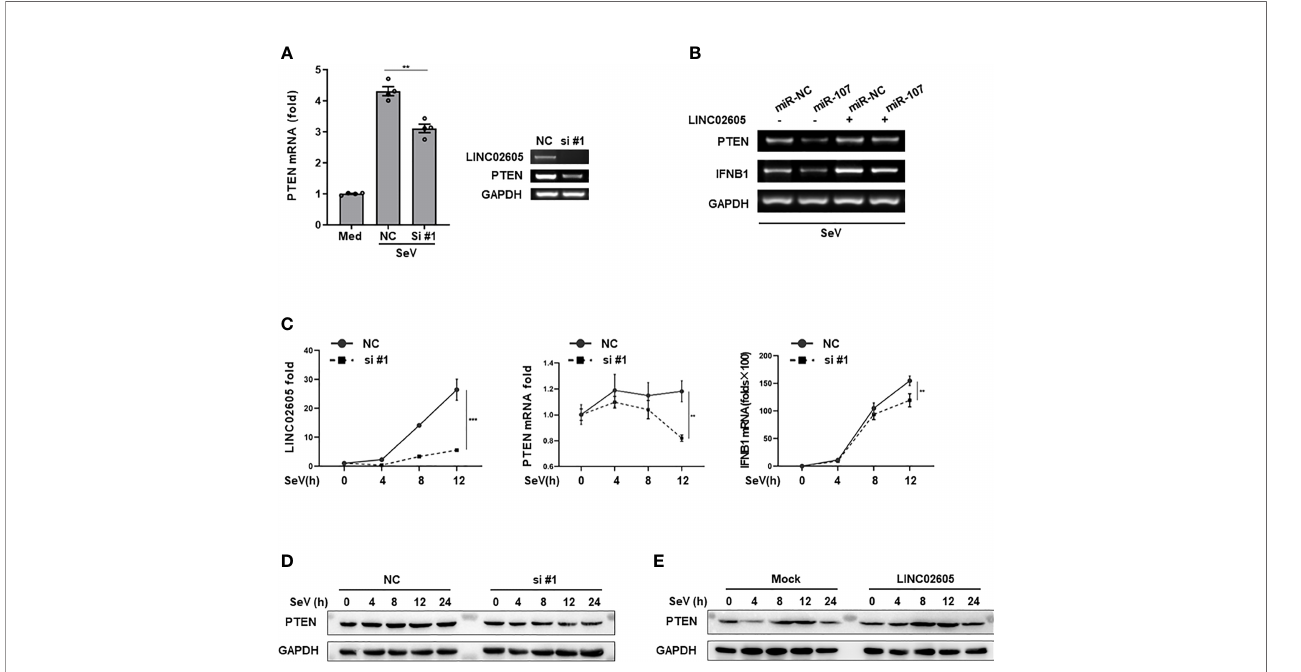
FIGURE 4 | LINC02605 targets hsa-miR-107 and enhances the expressions of PTEN (A) Q-PCR (left) and basic PCR (right) analysis of PTEN in control or LINC02605-silenced HEK293T cells infected with SeV for 12h. (B) of the mRNA expression levels of PTEN and IFNB1 were detected in miR-NC or hsa-miR-107 transfected WT HEK293T cells or LINC02605-overexpressing HEK293T cells infected with SeV for the indicated hours. (C) Q-PCR analysis of PTEN and IFNB1 mRNA expression in NC- or LINC02605-silenced HEK293T cells infected with SeV for the indicated times. (D, E) Western blot analysis of PTEN expression in LINC02605-silenced or -overexpressed HEK293T cells upon SeV infection for the indicated hours. All data shown are from one representative experiment of at least three independent repeats with similar results. ** P < 0.01 and *** P < 0.001 (Student ’ s t-test or